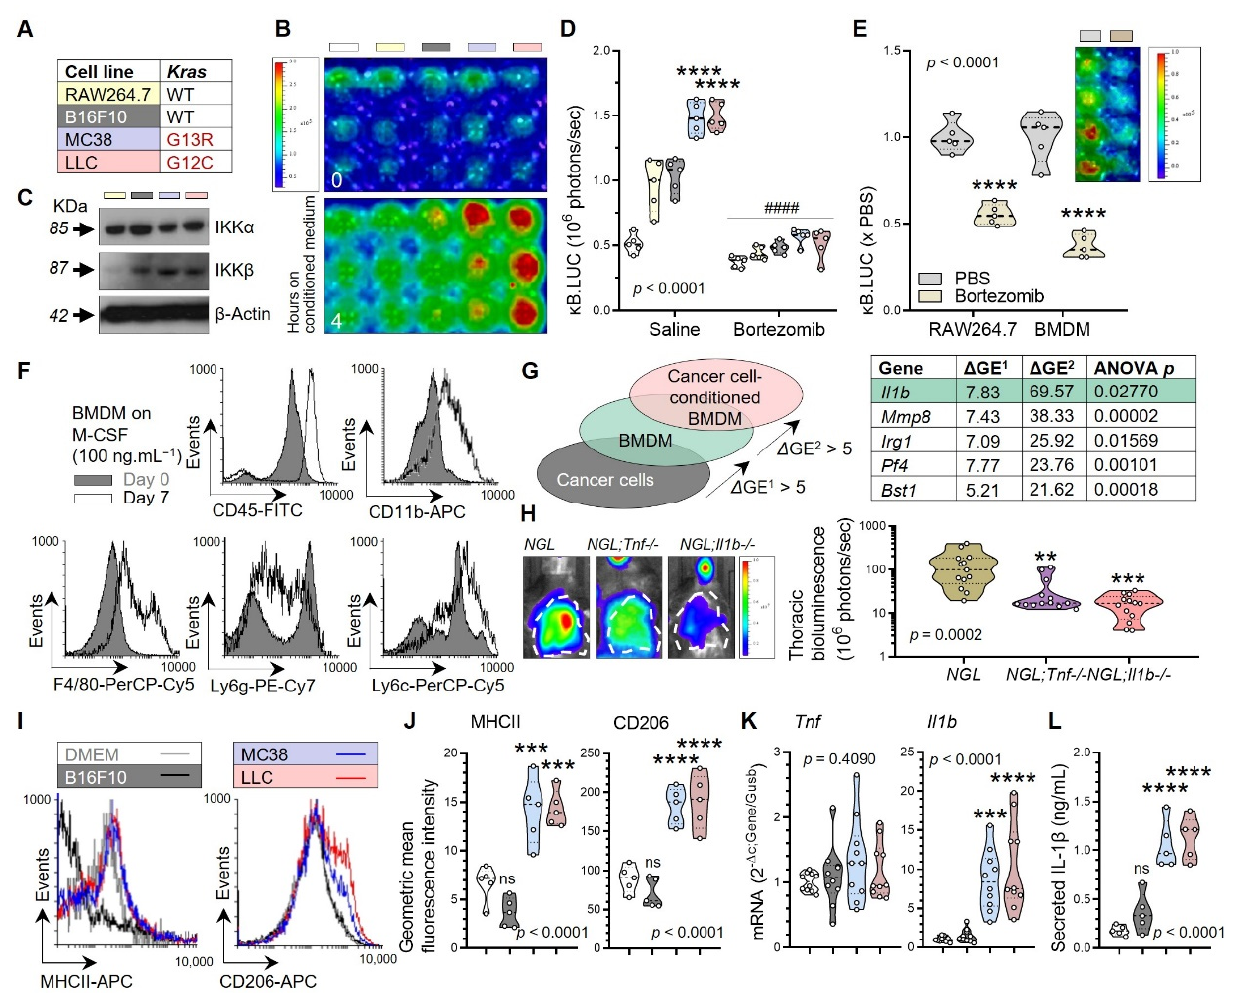
Figure 3. Tumor-secreted factors drive IKK β activation, differentiation, and IL-1 β secretion in mac- rophages. ( A ) Color-coded cancer cells with Kras mutation status. ( B – E ) Bioluminescent images with pseudo color scale ( B , E ), immunoblots ( C ), and data summaries ( D , E ) from exposure of RAW264.7 macrophages stably expressing p NGL ( B – D ) and murine bone marrow-derived macrophages